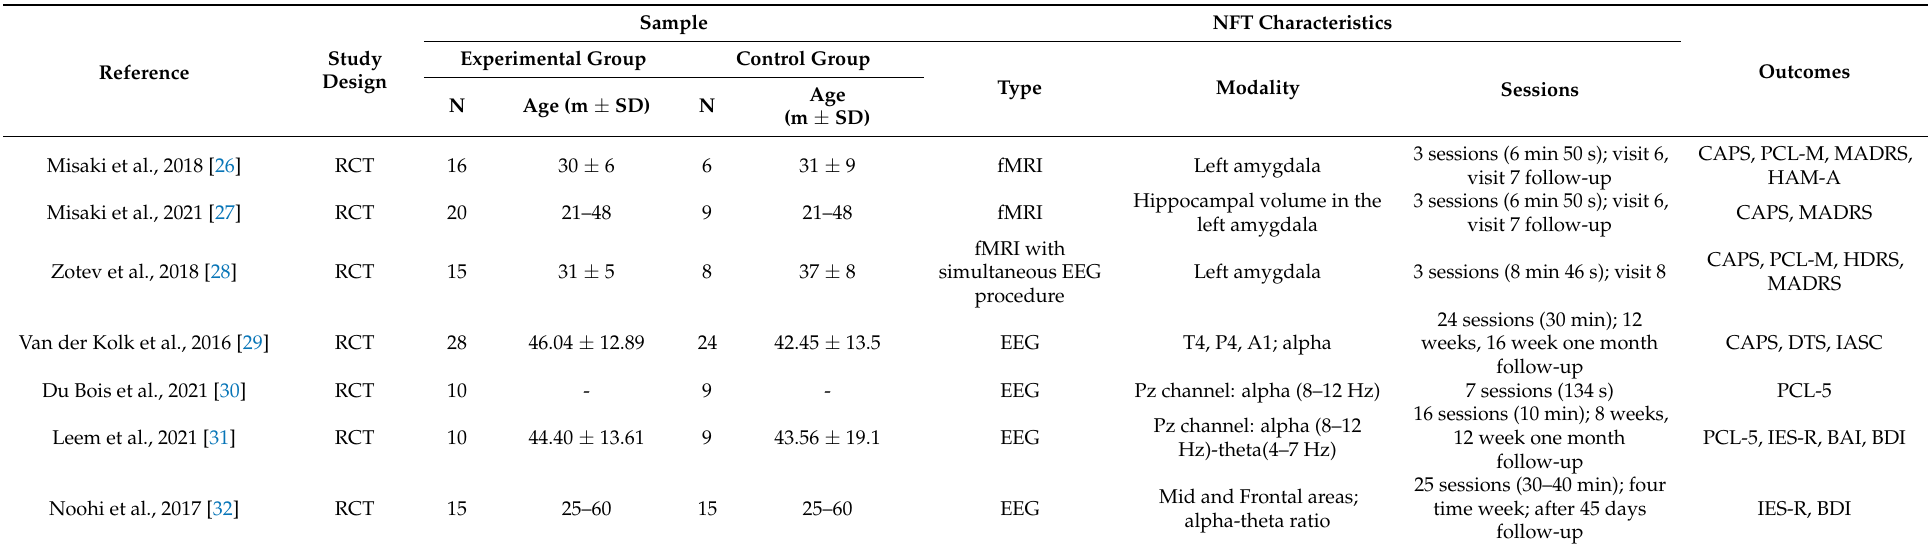
Table 1. Characteristics of studies included in